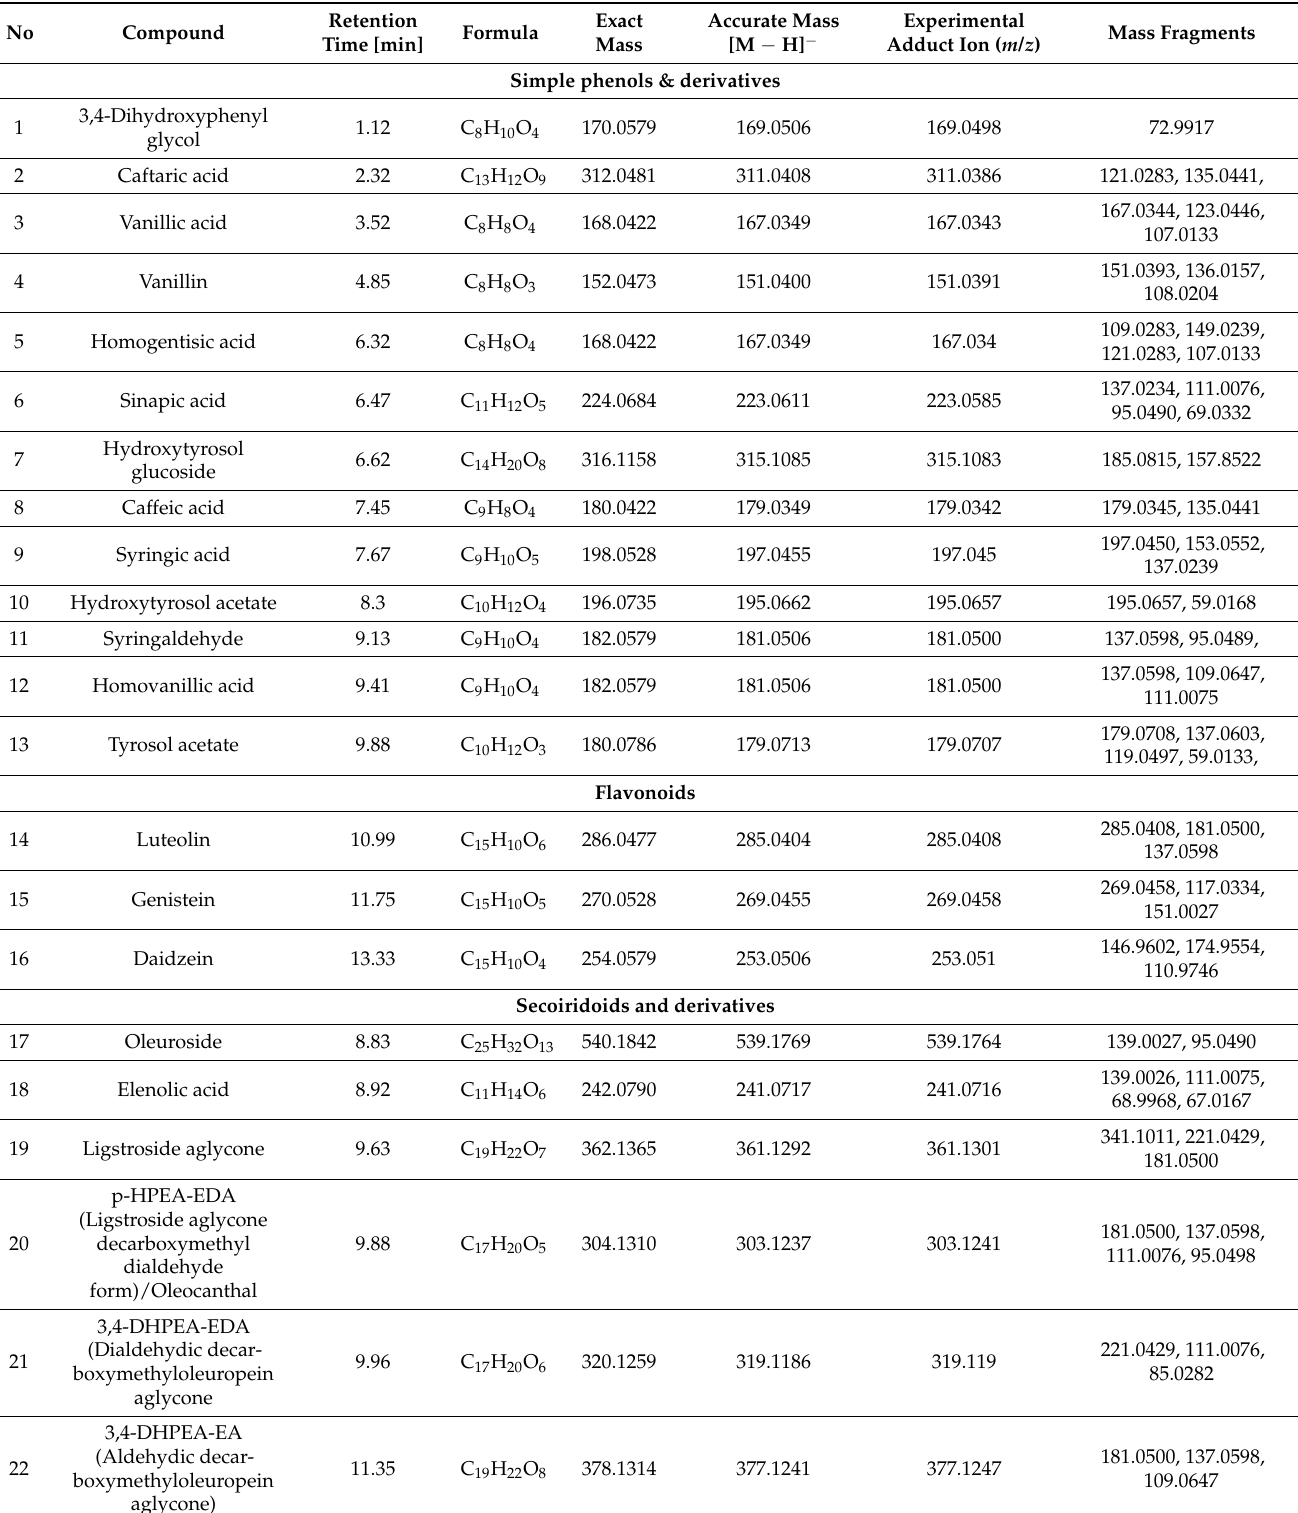
Table 2. Identification of biophenols in VOO and EVOO extracts by untargeted UHPLC-HRMS analysis of deprotonated precursors and fragment ions of specific components combined with data processing using Compound Discoverer